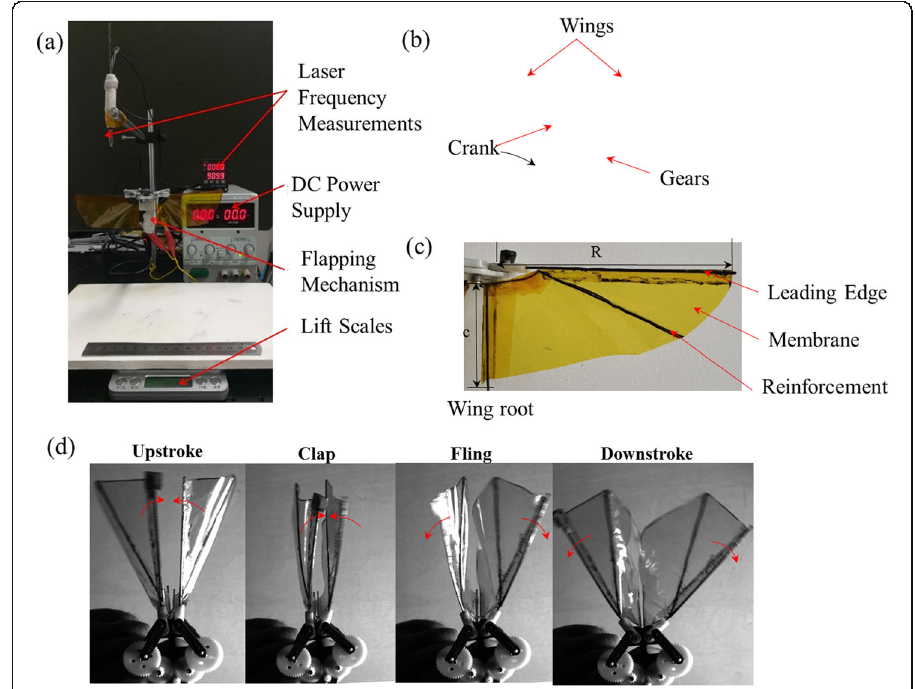
Fig. 2 Experimental apparatus and model ( a ) the fast lift measurement platform, ( b ) experimental test model, ( c ) Wing structure, ( d ) the flapping wings with clap-and-fling